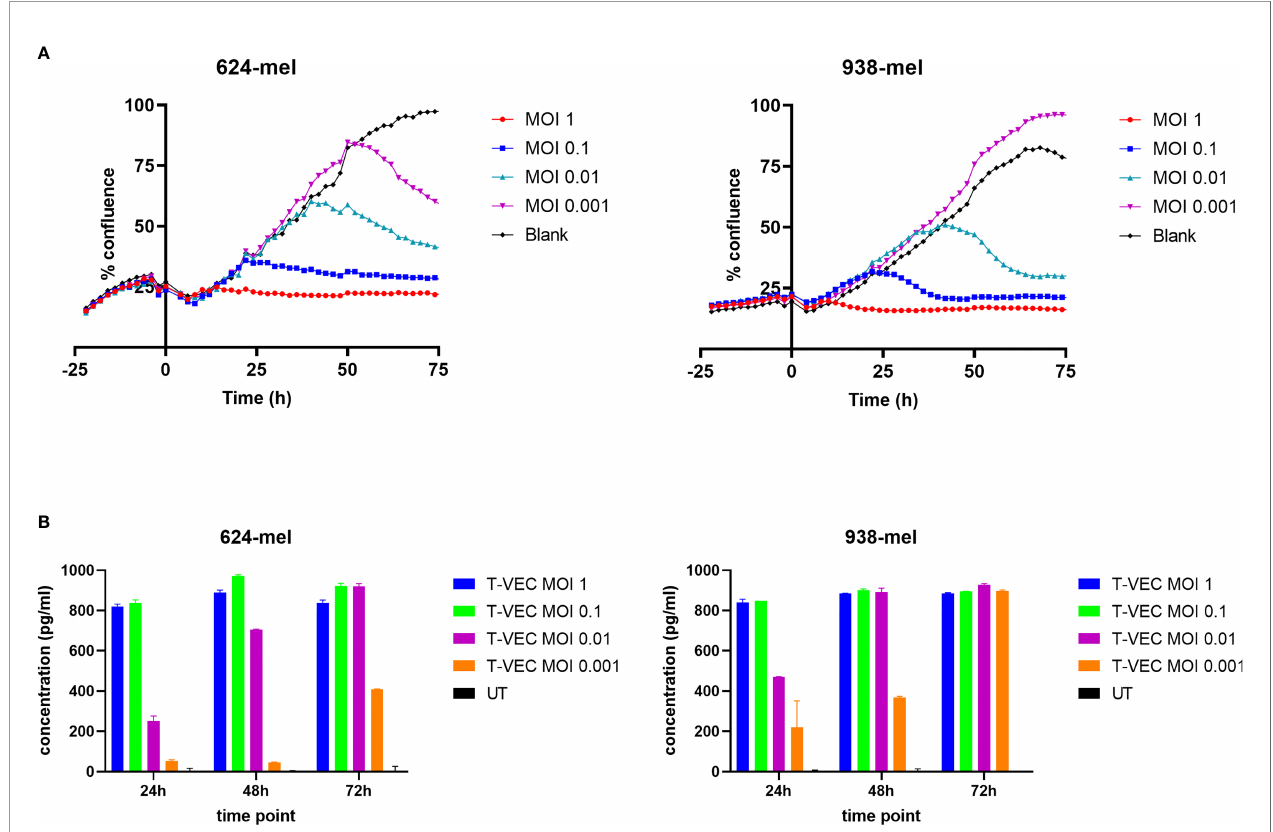
FIGURE 1 | T-VEC infection of melanoma cell lines. (A) The con fl uence of cells was analyzed in real time using the con fl uence image mask. T-VEC was added at the indicated MOIs at time 0. The left panel shows data for the 624-mel cell line and the right panel for the 938-mel cell line. Data points depict the mean of 3 replicate wells and the graphs show 1 representative experiment out of 3. (B) The secretion of GM-CSF after treatment with T-VEC at the indicated time points was measured by ELISA. The left panel shows data for the 624-mel cell line and the right panel for the 938-mel cell line. Data points depict the mean ± SD of 2 replicate wells and the graphs show 1 representative experiment out of 3. UT, untreated. Statistics left panel (624-mel): At 24h, all comparisons between the different conditions were highly signi fi cant (p < 0.0001), except for UT vs T-VEC MOI 0.001 (p = 0.0123) and T-VEC MOI 1 vs T-VEC MOI 0.1 (p = 0.6944, ns). At 48h, all comparisons between the different conditions were highly signi fi cant (p < 0.0001), except for UT vs T-VEC MOI 0.001 (p = 0.0302) and T-VEC MOI 1 vs T-VEC MOI 0.1 (p = 0.0002). At 72h, all comparisons between the different conditions were highly signi fi cant (p < 0.0001), except for T-VEC MOI 1 vs T-VEC MOI 0.1 (p = 0.0002), T-VEC MOI 1 vs T-VEC MOI 0.01 (p = 0.0002) and T-VEC MOI 0.1 vs T-VEC MOI 0.01 (p > 0.9999, ns). Statistics right panel (938-mel): At 24h, all comparisons between the different conditions were highly signi fi cant (p < 0.0001), except for UT vs T-VEC MOI 0.001 (p = 0.0001) and T-VEC MOI 1 vs T-VEC MOI 0.1 (p = 0.9988, ns). At 48h, all comparisons between the different conditions were highly signi fi cant (p < 0.0001), except T-VEC MOI 1 vs T-VEC MOI 0.1 (p = 0.9913, ns), T-VEC MOI 1 vs T-VEC MOI 0.01 (p = 0.9998, ns) and T-VEC MOI 0.1 vs T-VEC MOI 0.01 (p = 0.9987, ns). At 72h, all comparisons with the UT condition were highly signi fi cant (p < 0.0001), but differences between all other conditions were non-signi fi